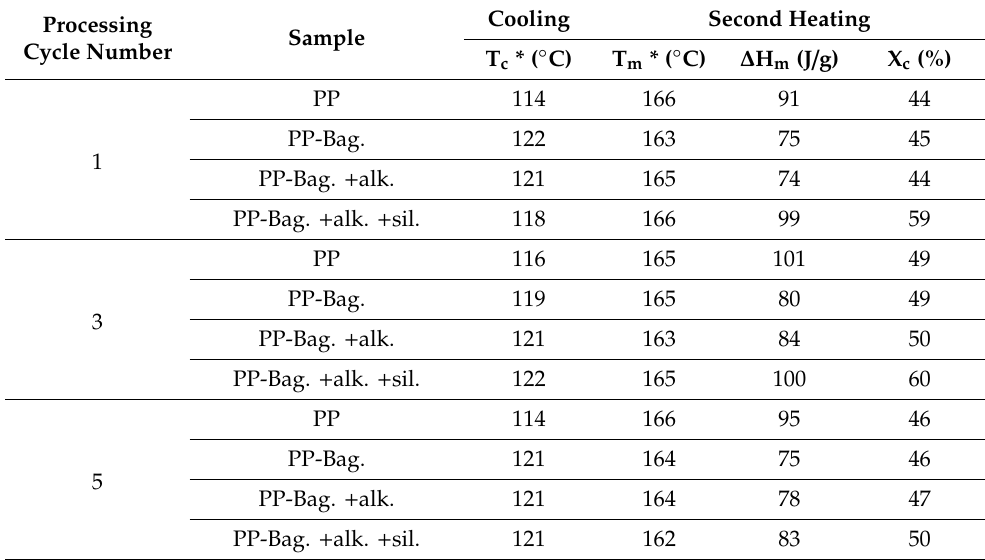
Table 4. Thermal degradation data of PP and PP-Bagasse biocomposites.